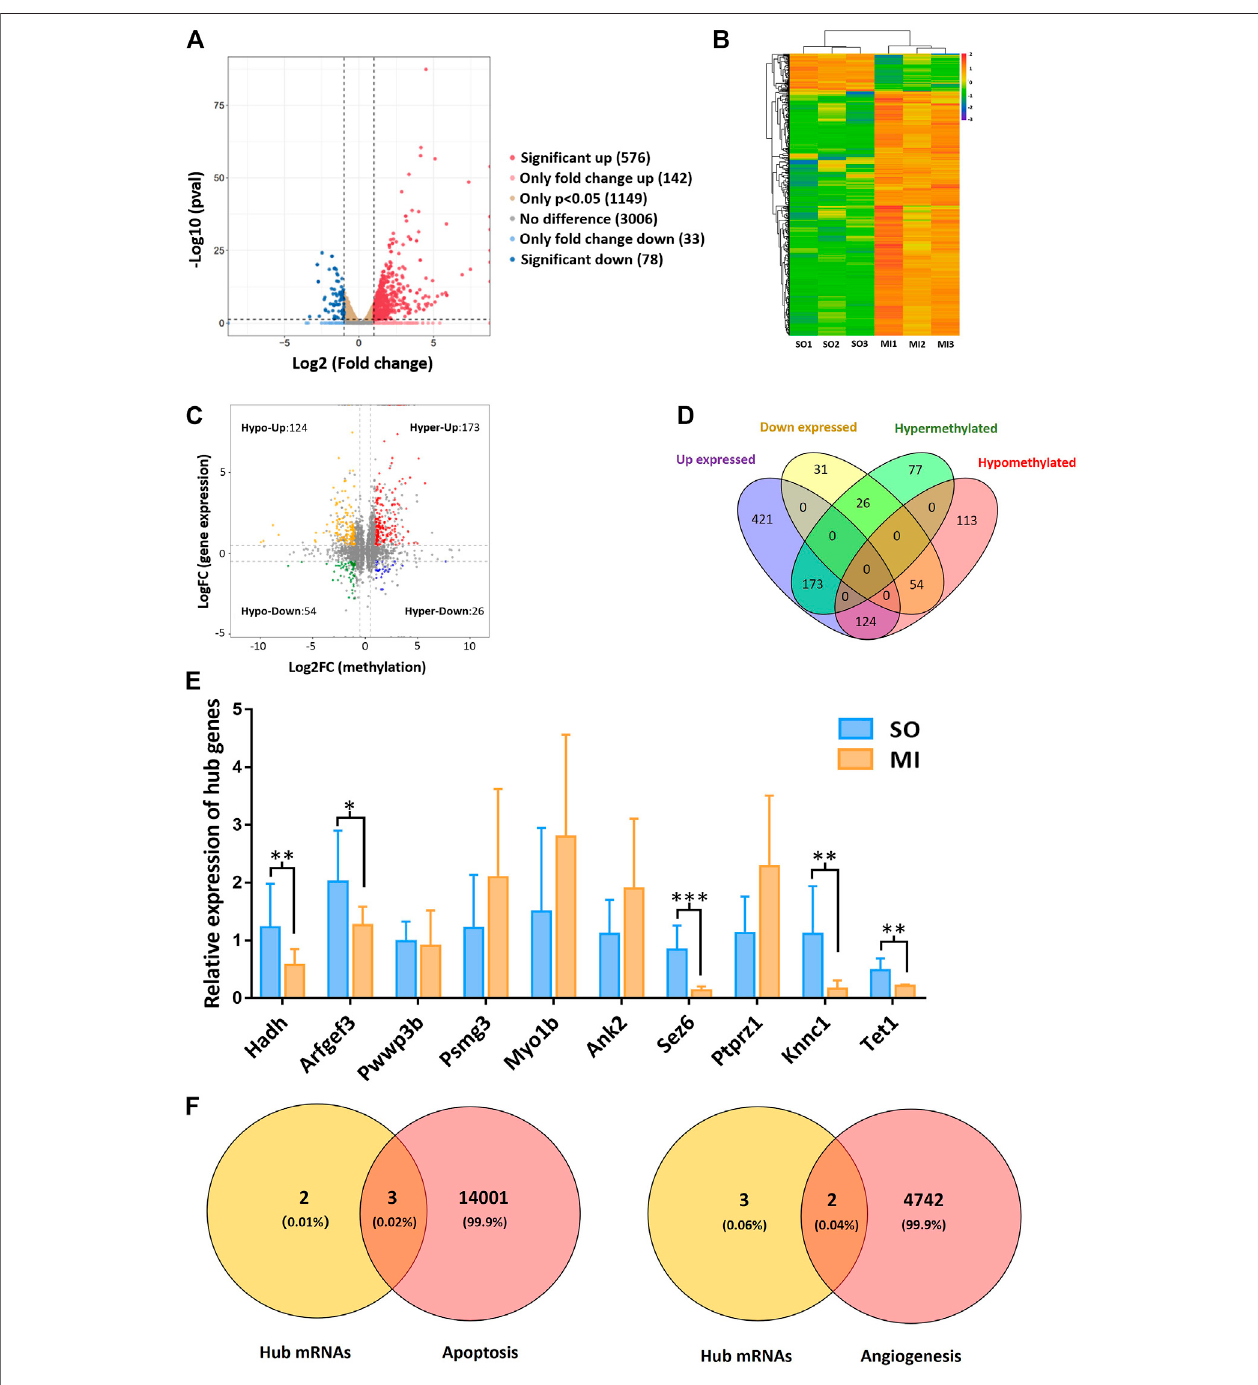
FIGURE 3 | Hub mRNAs associated with angiogenesis and apoptosis. (A) Volcano plots for differentially expressed mRNAs; (B) heatmap plots for differentially expressed mRNAs; (C) four-quadrant graphfor m 6 Amethylationregulated mRNAs; (D) Venn diagram showing therelationships between m 6 Amethylation and mRNAs expression; (E) validation of the top 10 hypermethylated and downregulated mRNAs in MI rats; (F) Venn diagram showing the relationship between hub mRNAs and apoptosis/angiogenesis. Hypo-Up, hypomethylated and upregulated; hyper-Up, hypermethylated and upregulated; Hypo-Down, hypomethylated and downregulated; hyper-Down, hypermethylated and downregulated. SO, sham operated; MI, myocardial infarction. * p < 0.05, ** p < 0.01, *** p < 0.001.